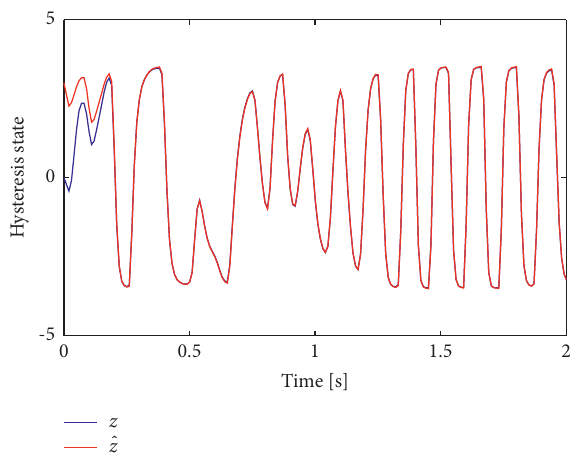
Figure 18: Time history of the hysteresis